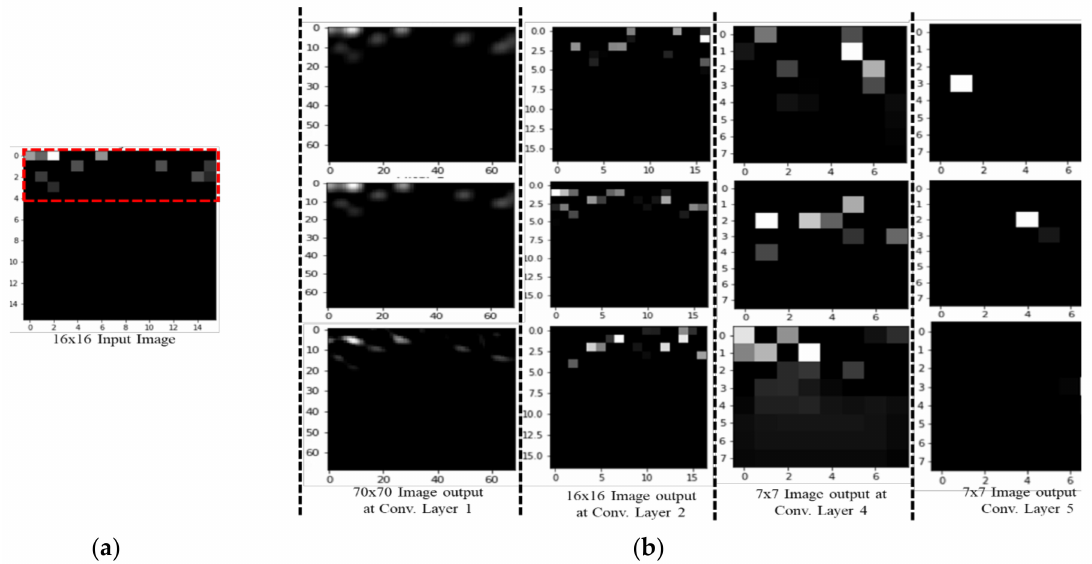
Figure 9. Images for ZFNet. ( a ) Input image. ( b ) Output image with di ff erent convolutional